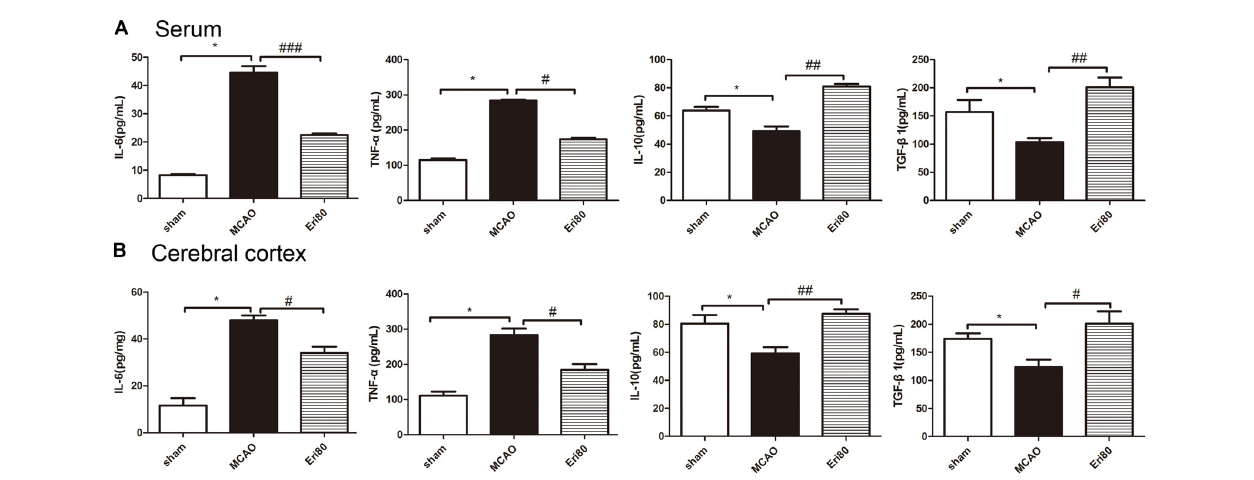
FIGURE 4 | Eriodictyol decreased MCAO-induced inflammation. The levels of IL-6, TNF- α , IL-10, and TGF- β 1 in the serum (A) and cerebral cortex (B) in each group were measured by ELISA kits (The data are presented as mean ± SEM, n = 6, * P < 0.05, vs. sham group; # P < 0.05, ## P < 0.01, ### P < 0.001, vs. MCAO